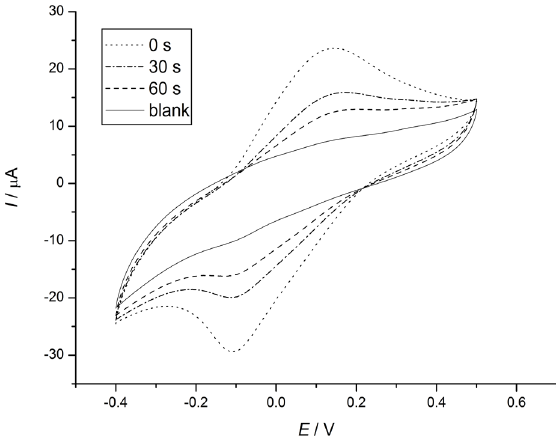
Figure 3 - Cyclic voltammograms recorded at a PMB-modified and 0.05 mol L 1 acetate buffer electrode in 0.1 mol L 1 NaNO 3 solution (pH 5.0) before and after two successive Fenton attacks; scan rate = 0.05 V s 1